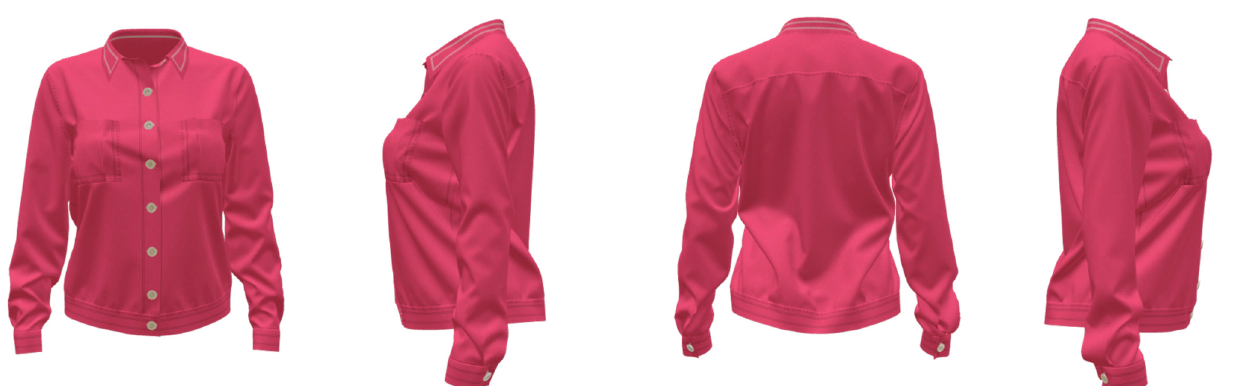
Figure 12. Final visualization (render) of the denim-style womenswear jacket with embedded antenna behind the metallic buttons (Figures 10 and 11) seen in various posture positions.